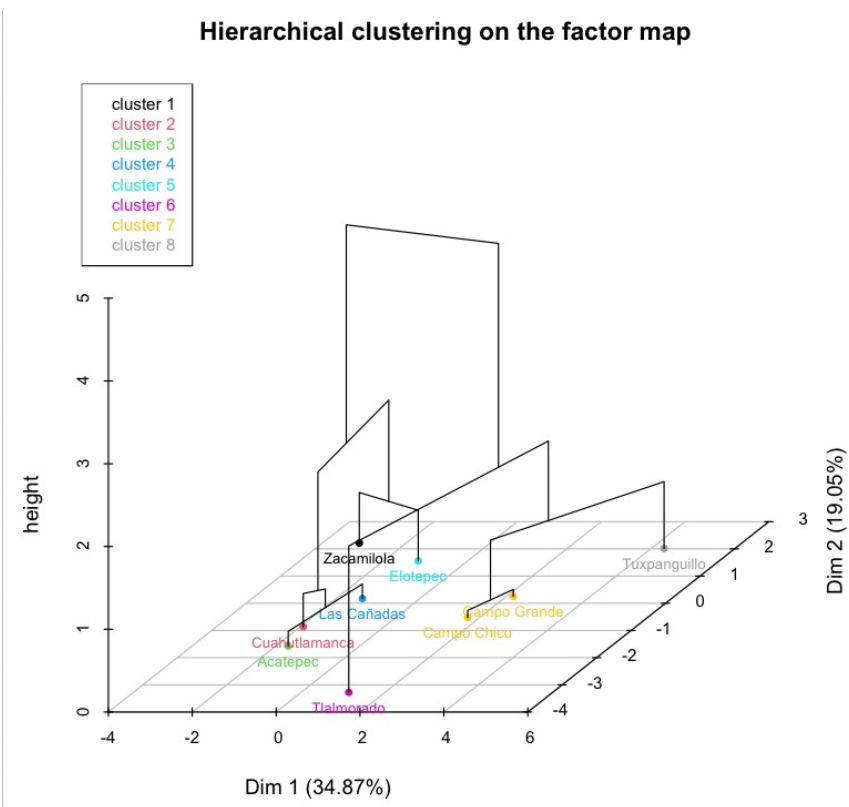
Figure 12 Dendrogram and grouping of the study localities. Figure 12. Dendrogram and grouping of the study Table 5. Soil analysis of the three natural study populations. Soil analysis of the three natural study populations.